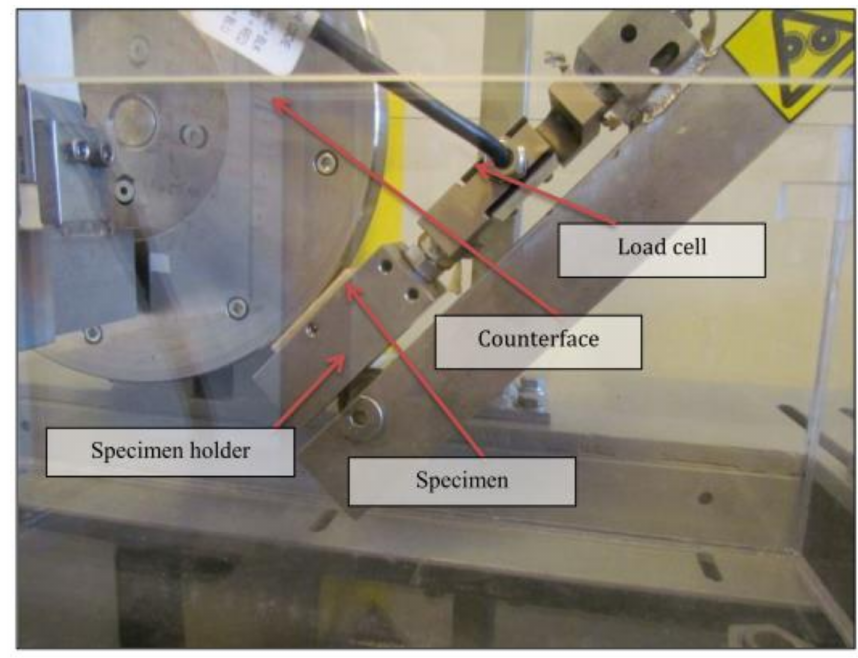
Figure 3. Block-on-ring machine configuration